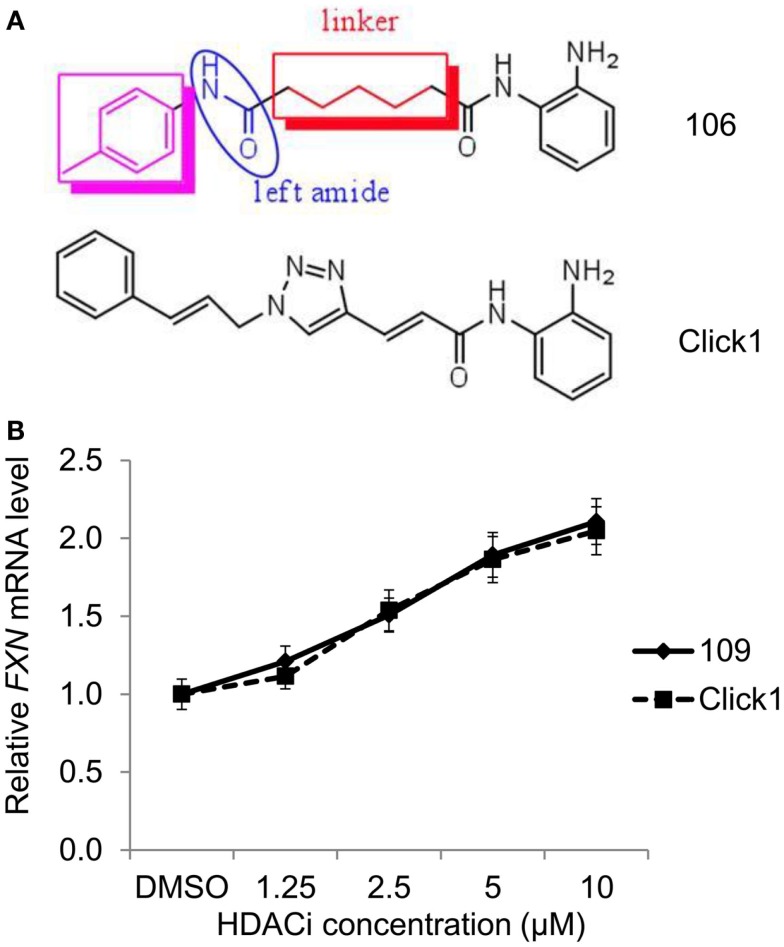
HDAC inhibitors with improved pharmacological properties yield comparable increases in FXN mRNA in FRDA neuronal cells as the first-generation inhibitors. (A) Structures of compound 106 and Click-1, showing replacement of the left amide in 106 with an unsaturated bond, and introduction of a triazole in the linker region in Click-1. An unsaturated bond was also introduced adjacent to benzamide to prevent benzimidazole formation, as observed for 106 and other pimelic 2-aminobenzamides. (B) Quantitative RT-PCR was used to compare the effects varying concentrations of HDACi 109 and Click-1 on FXN mRNA in FRDA neuronal cells. mRNA levels were arbitrarily set to 1.0 for the DMSO control. Error bars = SEM of triplicate measurements.